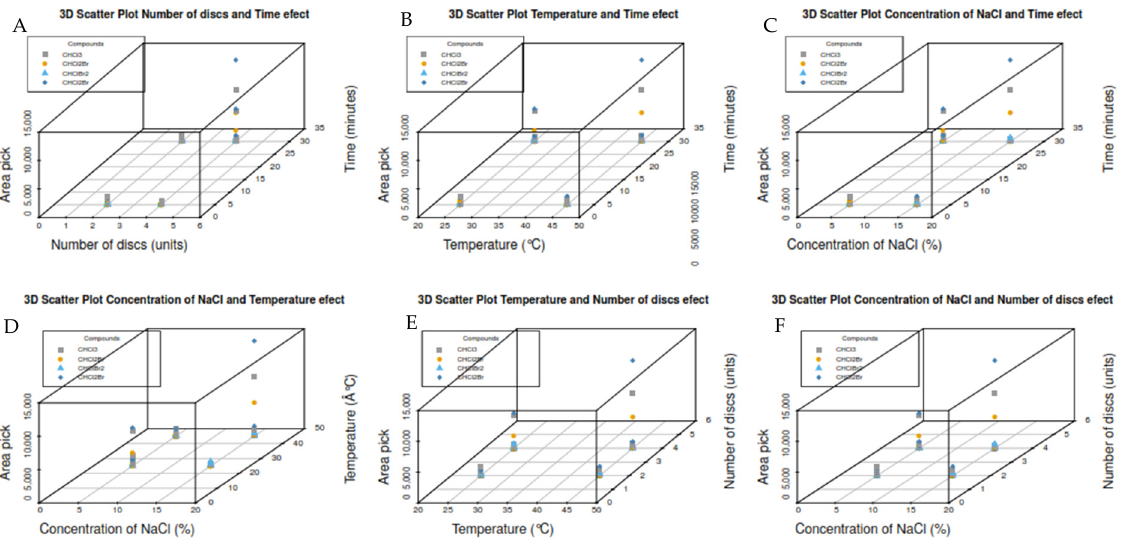
Figure 9. ( A – F ) A 3D Scatter plot for optimization of microextraction conditions in the new SPME configuration at 2 mm of the distance between discs.